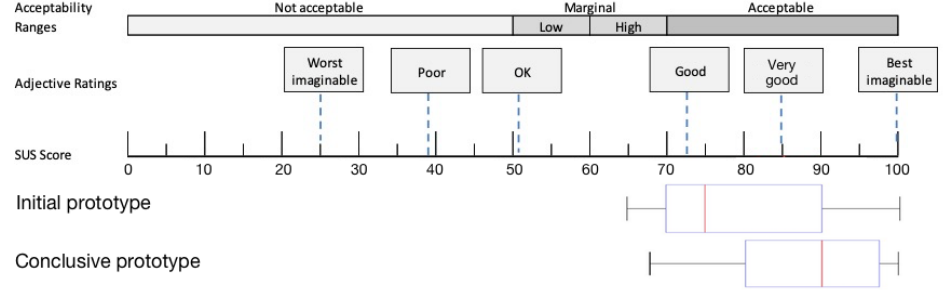
Figure 5. System usability score of the initial and conclusive prototype shown as horizontal box plots (initial prototype n = 10, conclusive prototype n =